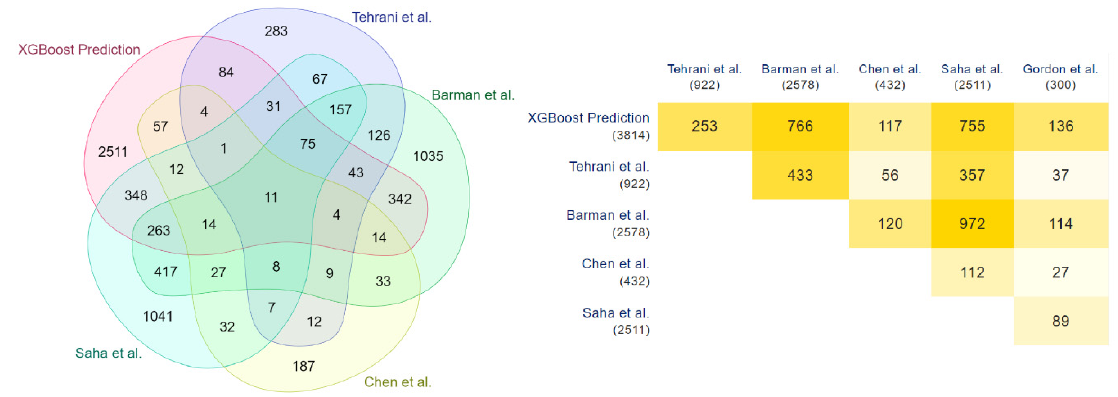
Figure 4. Overlapping of ML-DTD and Gordon et al. predicted COVID-19 human drug targets.